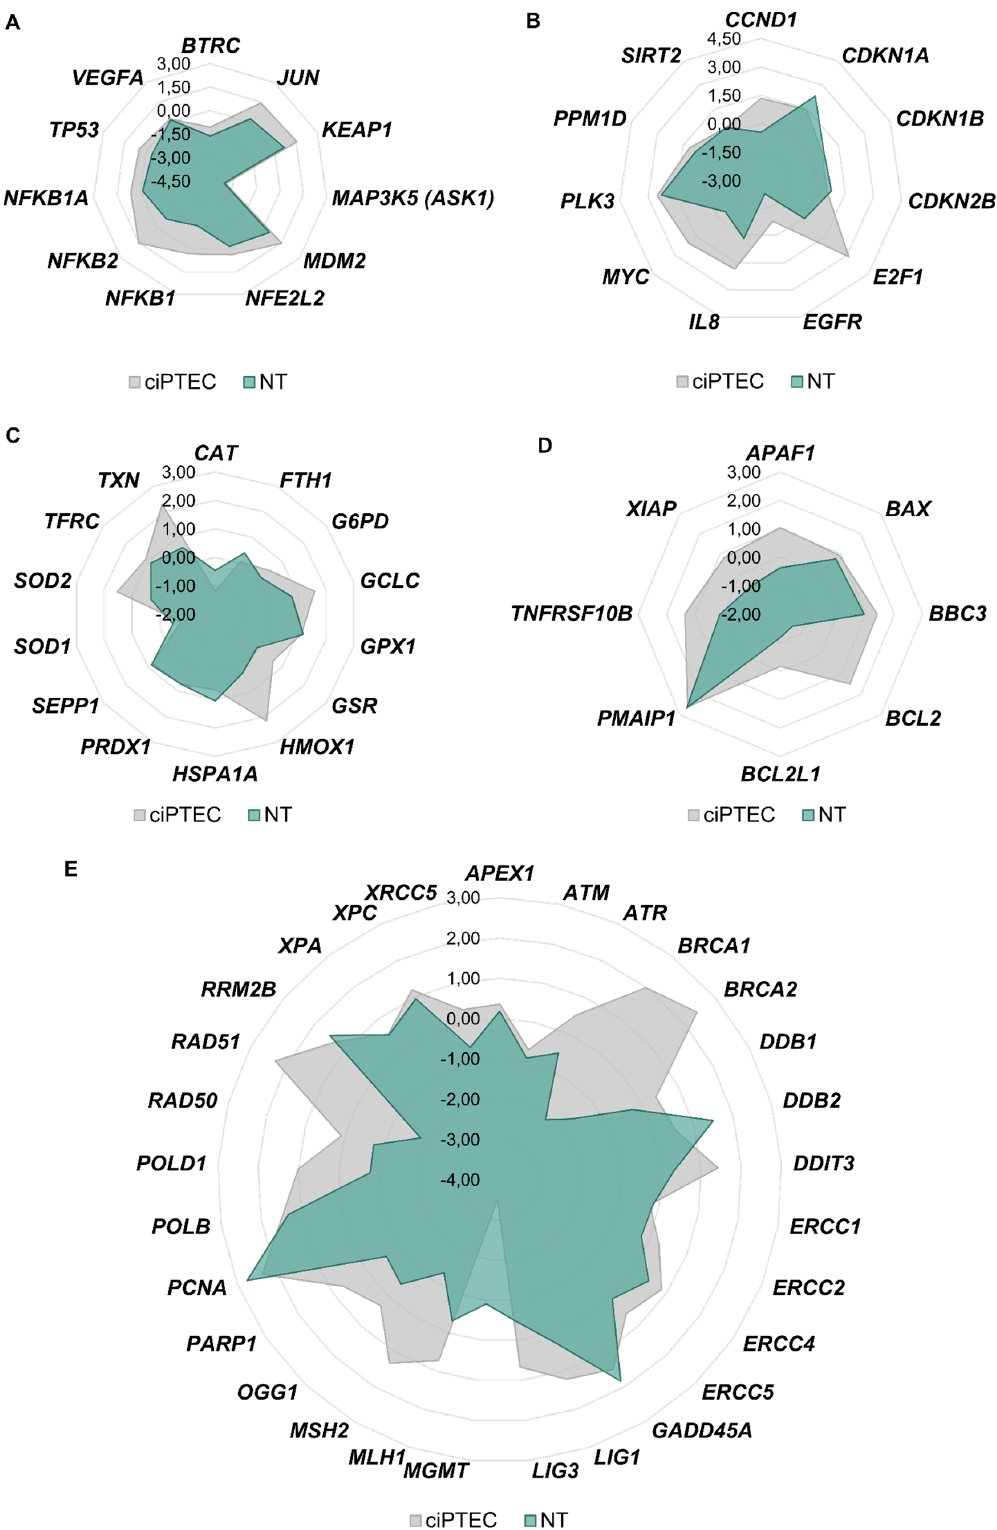
Figure 6. ciPTECs and normal kidney cells were treated with 20 µM cisplatin for 24 h, and gene expression analysis was performed with high-throughput RT-qPCR. Genes were grouped into the clusters of transcription factors ( A ), cell cycle and proliferation ( B ), oxidative stress response ( C ), apoptosis ( D ) and DNA damage response/repair ( E ). Gene clusters were arranged in network diagrams.